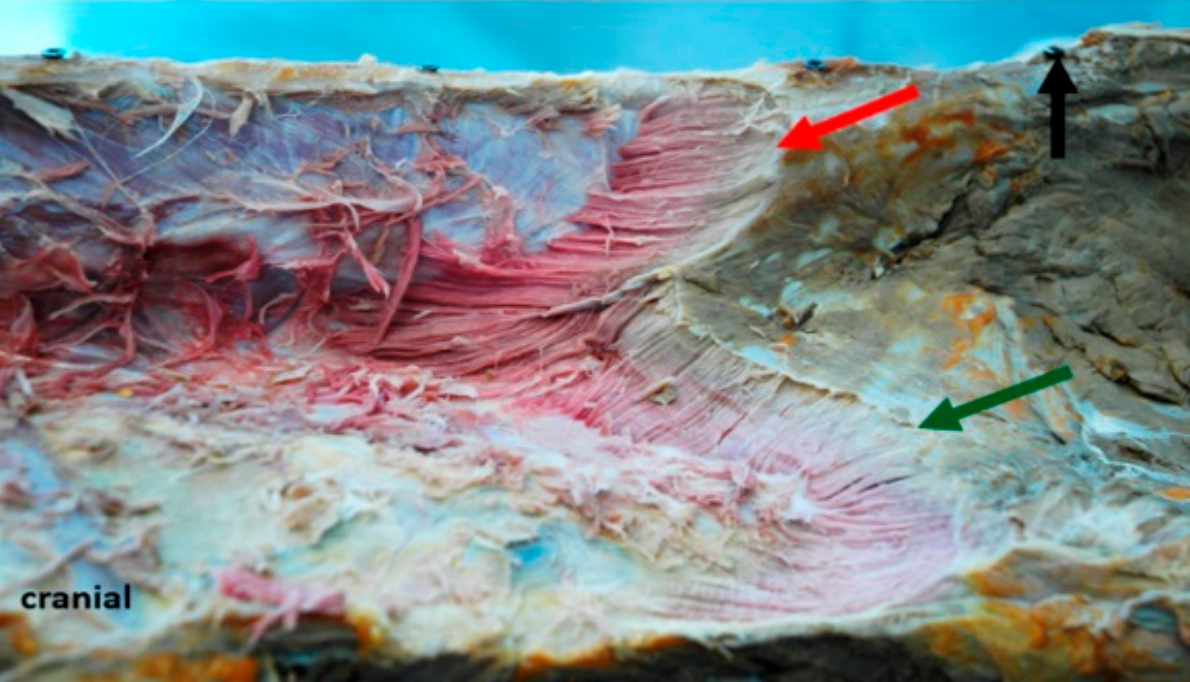
Figure 4. Left cranio-lateral view of a formalin-fixed horseback, showing the partly dissected lumbar LG in compartment D . The red arrow is pointing at the slim dorsal muscle belly that originates at the dorsal processes of the sacrum. The green arrow points at the flat ventral muscle portion running from the iliac crest. Muscle layers have been removed from cranial to caudal to expose fascicles from their origin to the insertion. The screw that is drilled into the dorsal process of the sacrum (black arrow) served as a reference point.